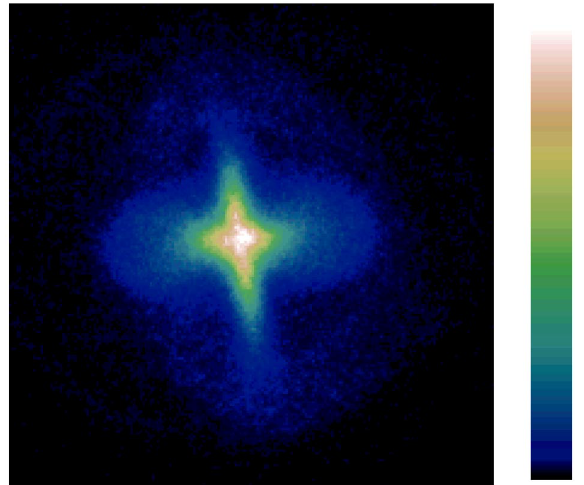
FIG. 6. (Color) A transverse beam image taken on NTX. The scale is 3 cm (cid:5) 3 cm . The image intensity is represented quali- tatively by the linear color scale at the